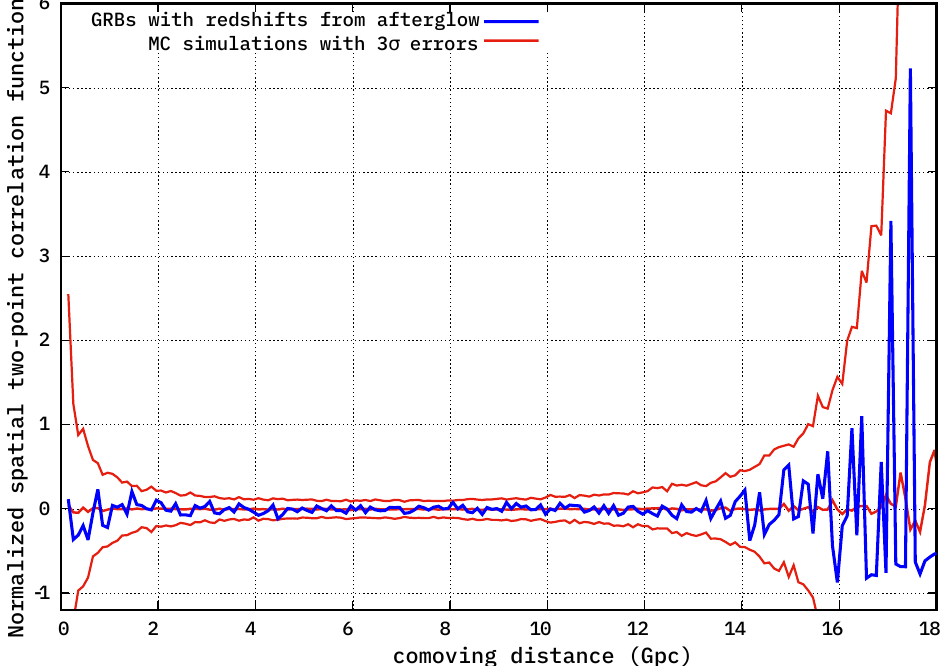
Figure 10. The Spatial Two-Point Correlation Function of the afterglow-based redshift fraction (blue) with the corresponding MC simulations’ mean and ± 3 σ errors (red